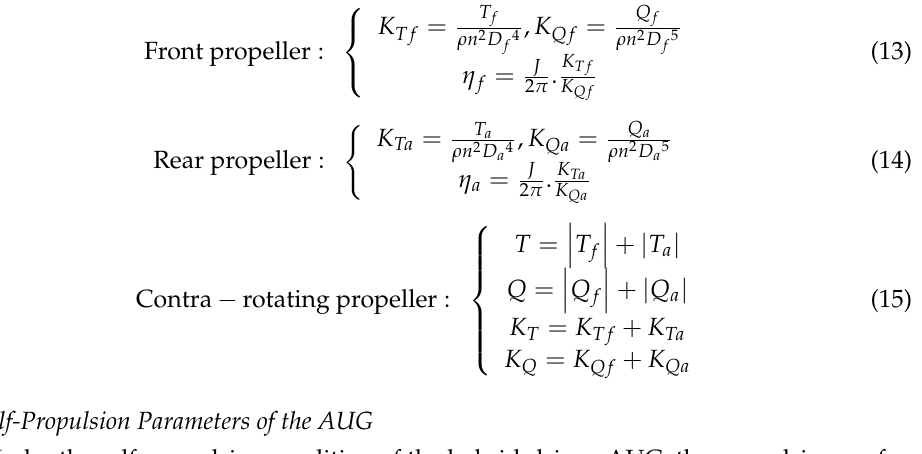
Figure 1. The force analysis of the AUG from the perspective of the vertical section. The open water performance formula of CRP based on ITTC is shown in Equations (13) and (15)